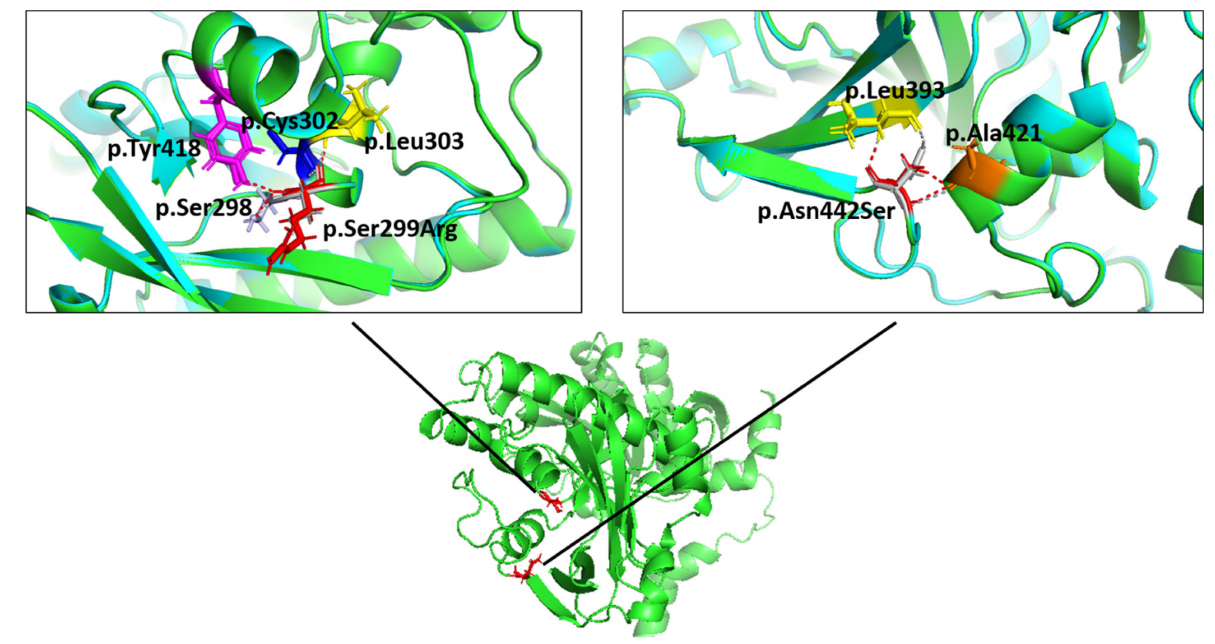
Figure 5. Molecular modelling of the FKTN variants p.Ser299Arg (left panel) and p.Asn442Ser (right panel), with structures calculated using ColabFold [23]. The influence of the variants on the molecular structure was analyzed using PyMOL Molecular Graphics System (version 2.5.2, Schrodinger LLC, New York, NY, USA). The protein backbone is shown in green for the wildtype and in cyan for the respective mutant. No major structure change was observed in the alignment between the wildtype and mutant proteins, as evidenced by the protein backbone overlay. The polar contacts were calculated using PyMOL and are shown as grey or red dashed lines for the wildtype or mutant proteins, respectively. The serine at position 299 (left panel, p.Ser299, grey) has polar contacts to p.Ser298 (purple), p.Cys302 (blue), and p.Leu303 (yellow). In the p.Ser299Arg mutant (left panel, red), an additional polar contact to Tyr418 (magenta) was observed. The asparagine and serine at position 442 (right panel, grey: p.Asn442, red: p.Ser442) had polar contacts to p.Ala421 (orange) and p.Leu393